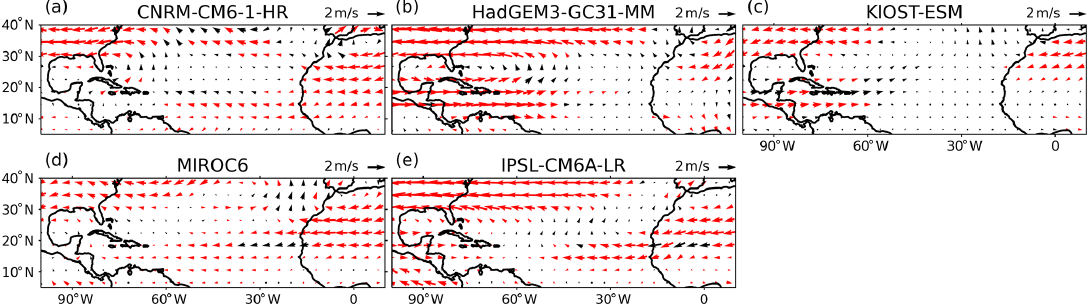
Figure 8. Difference (future minus historical) in the hurricane-season averaged deep layer steering flow for the five selected CMIP6 models. Statistically significant differences between the future and historical period at the 95% level are shown in red and are calculated using Welch’s t test.